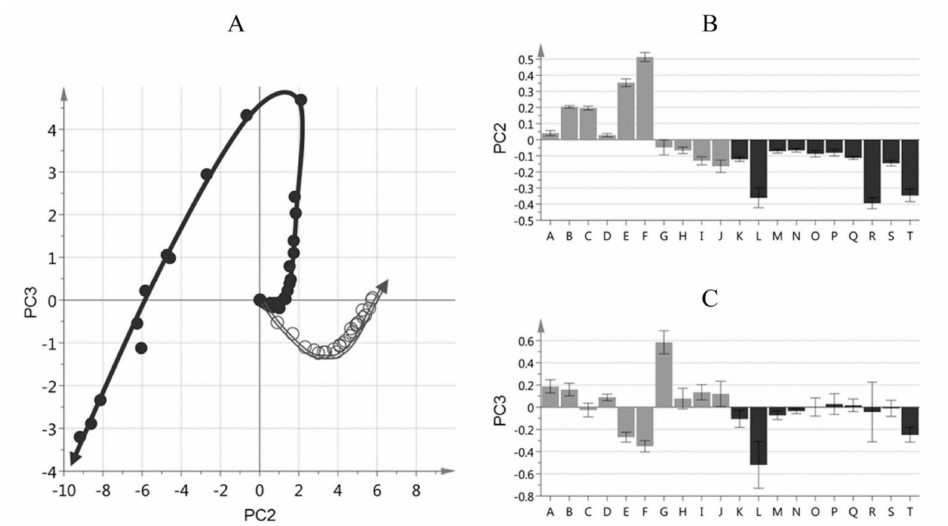
Figure 36. Oxidation-product profiles of mayonnaise stored at two different temperatures and followed as a function of time. ( A ) Score plot of PC 2 vs PC 3. The arrows in the score plots indicate the trajectory through time: the base of the arrow is time point zero, the arrowhead is located at the last time point. Samples at elevated ( • ) and ambient ( ) temperature are respectively stored (cid:35) for 53 and 203 days. ( B , C ) Loading plots of PC2 and PC3, respectively, where gray bars represent hydroperoxides and black bars aldehydes. A–T correspond to the annotations in Table 5. Reprinted with permission from [135]. Copyright 2018, American Chemical Society.